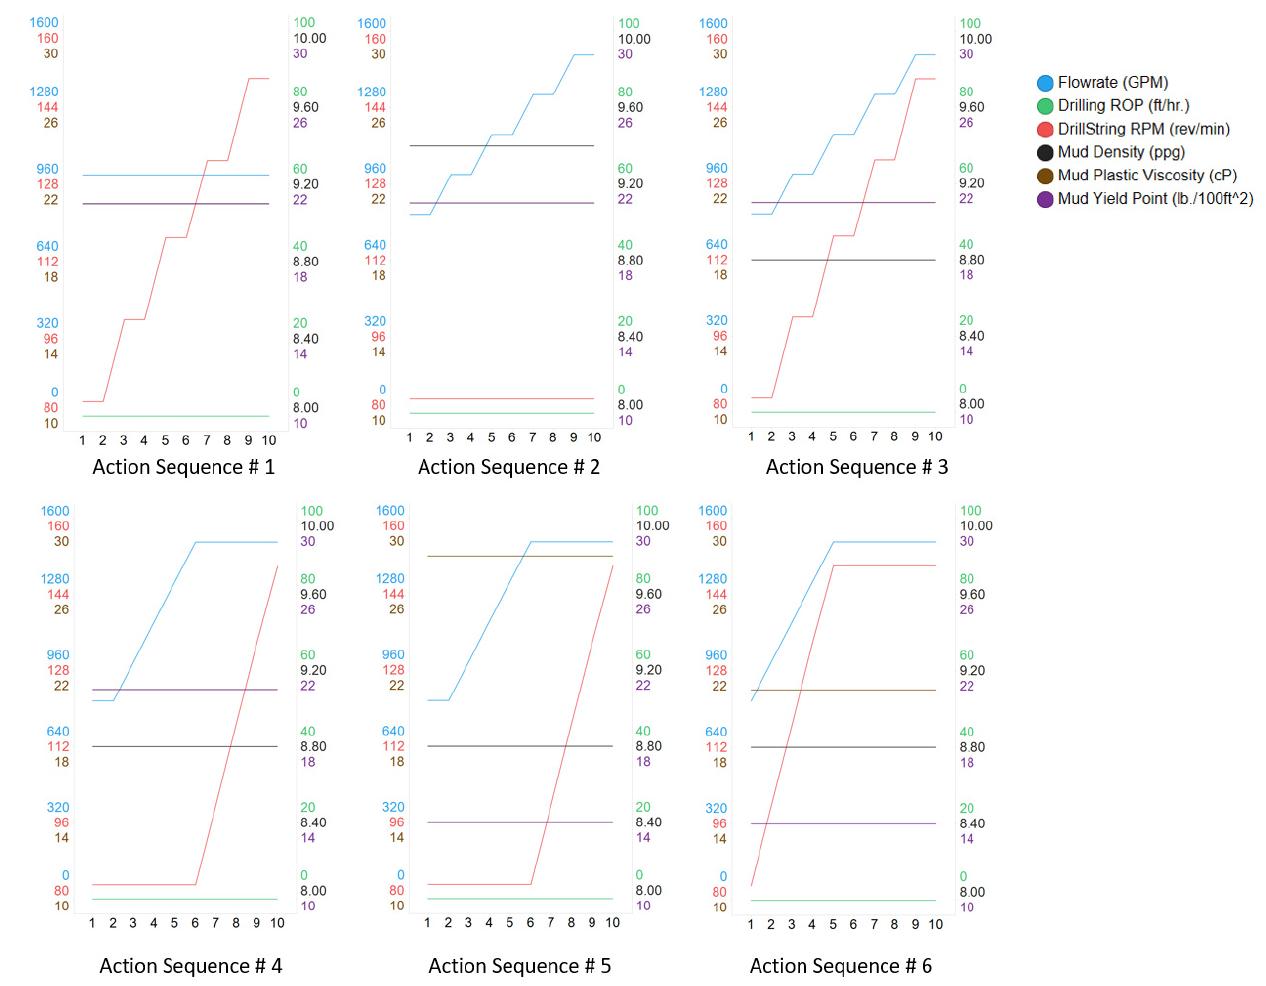
Figure 17. Six action sequences simulated in this work and discussed in detail in the text.